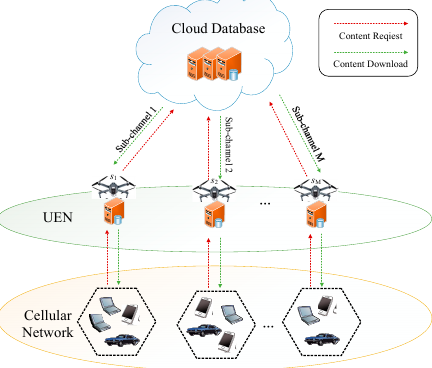
Figure 1. UAV edge